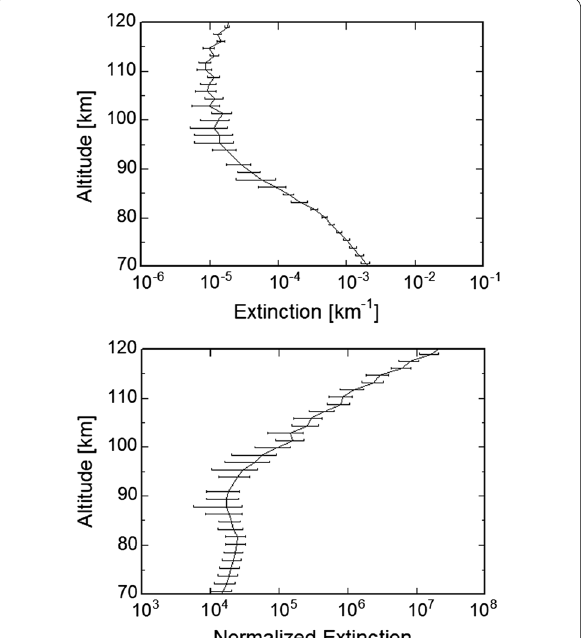
Fig. 5 Example of a vertical profile of extinction coefficients (top panel) and the corresponding normalized extinction coefficients (bottom panel) for orbit 137, order 149 (Sep. 05, 2006, latitude 79N ◦ , longitude 237 ◦ ). The average errors are almost 26% for the extinction coefficient and 42% for the normalized extinction